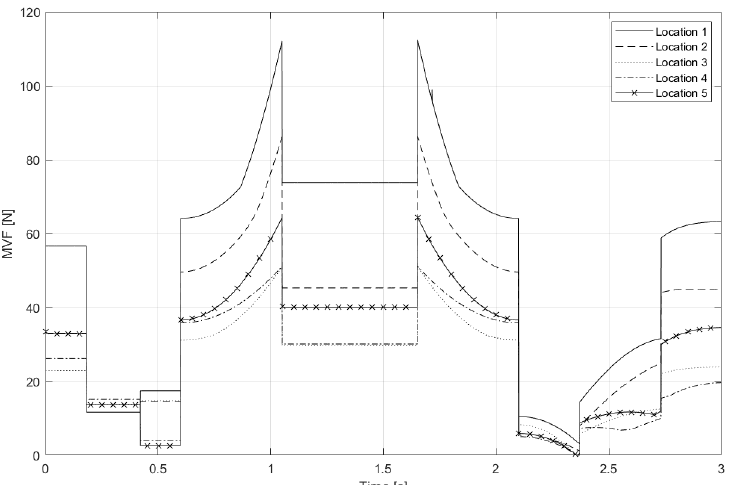
Figure 12. Minimum vacuum force required during the trajectory of Figure 11 as a function of